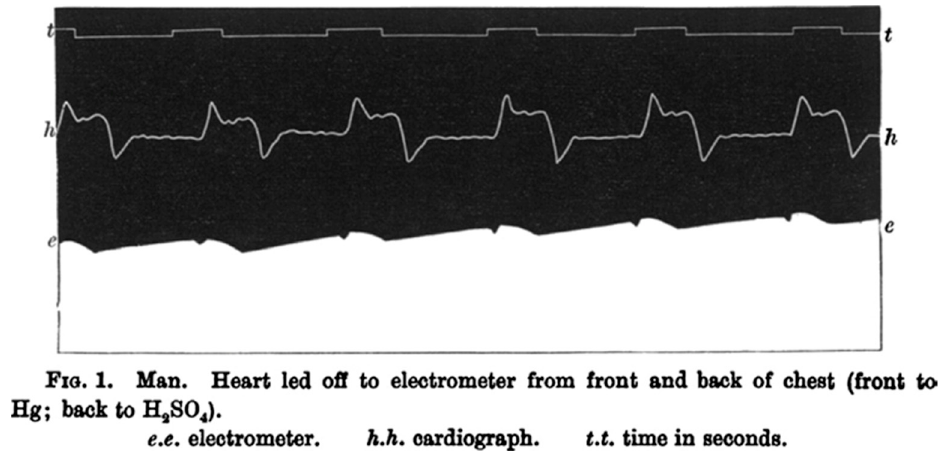
Figure 1. First human “electrogram”, performed by Waller, showing an electrical activity preceding every heartbeat.